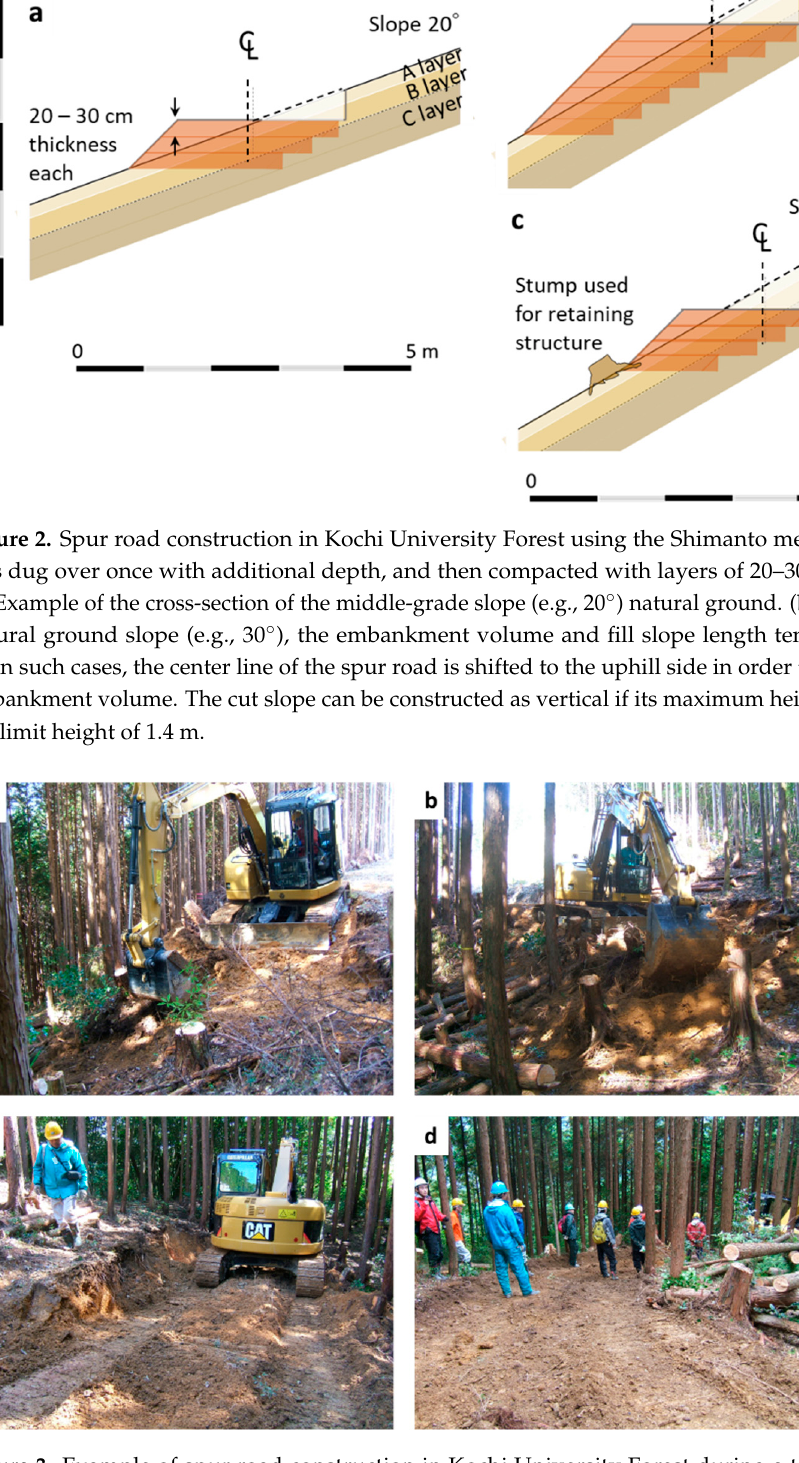
Figure 3. Example of spur road construction in Kochi University Forest during a training course. The excavator dug over the soil for extra depth ( a ). Then, the loose soil was mixed using the bucket, spread over the designated road width ( b ), and compacted by the crawler ( c ). The compaction was carried out for a few layers with a thickness of 20–30 cm each up to the level of the existing road height ( d